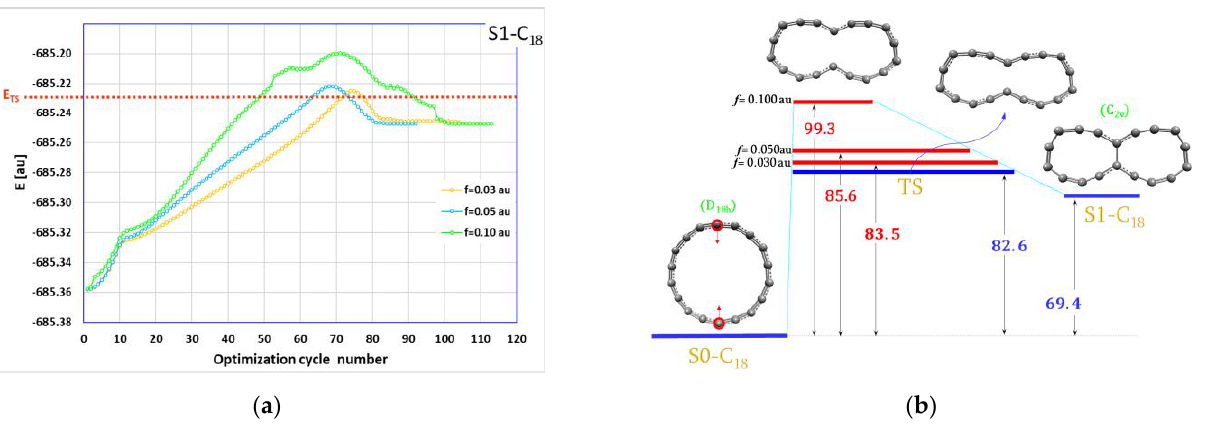
Figure 1. ( a ) The algorithmic reaction path (the geometry optimization history) with the marked transition state energy value; ( b ) the energy diagram with the estimated upper limit of the energy demand for the formation of the S1-C 18 molecule. All values in the energy diagrams are in kcal/mol.